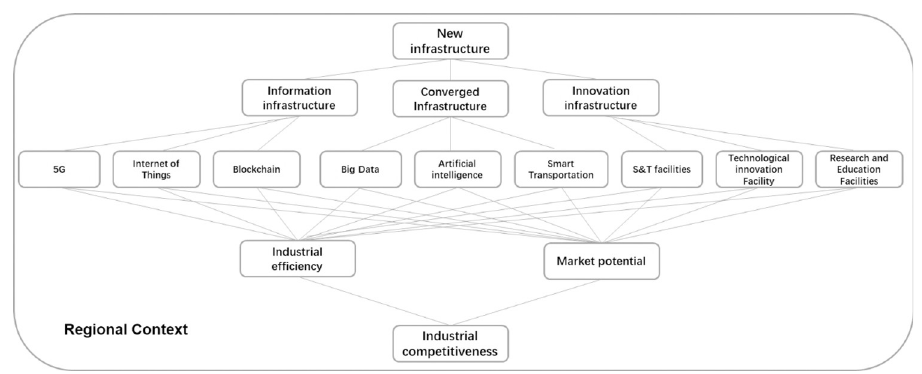
Fig 1. Framework for new infrastructure and industrial